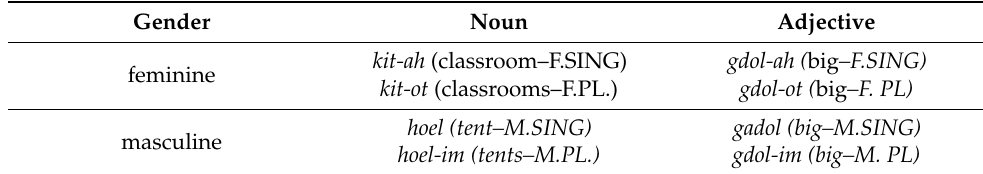
Table 6. Noun–adjective agreement in Spanish. Gender Noun